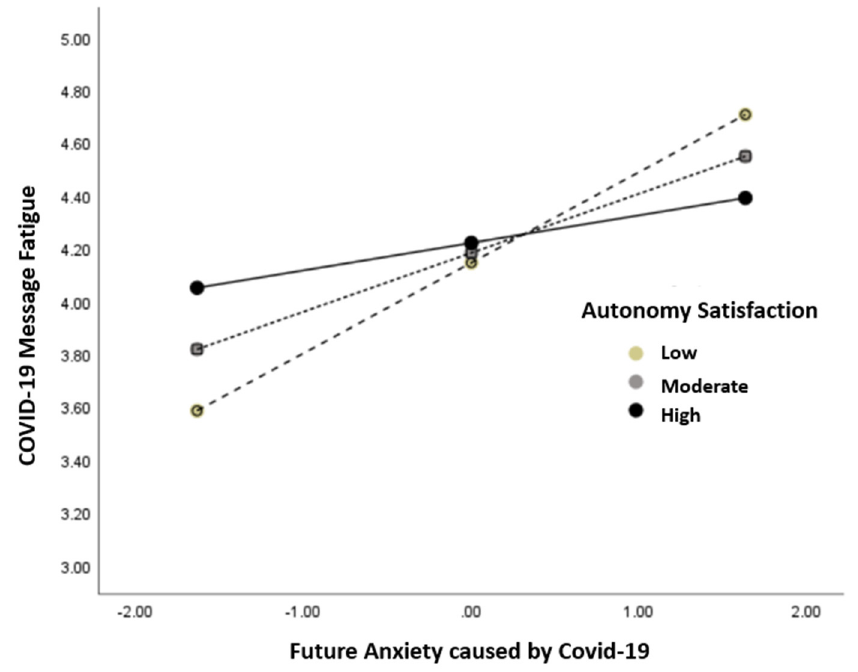
Figure 4. Future Anxiety and Message Fatigue: Moderation by Autonomy Satisfaction.